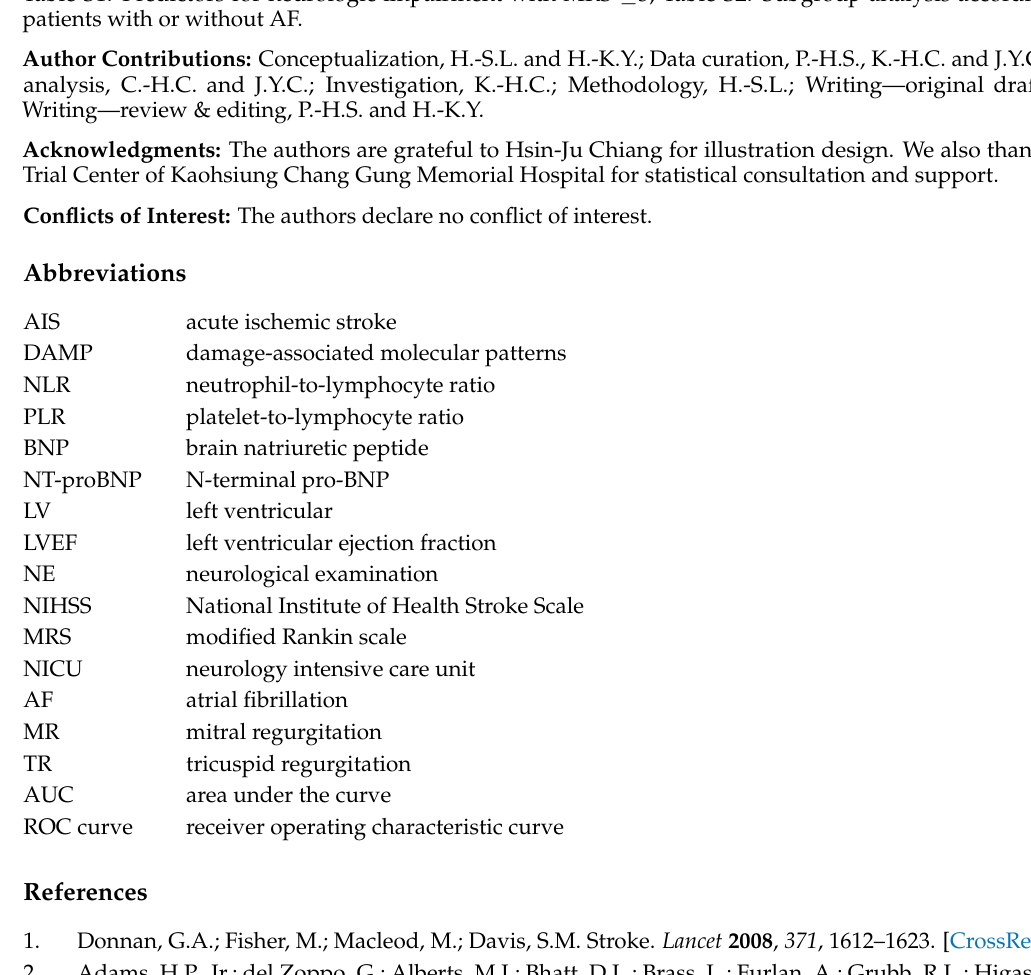
Table S1: Predictors for neurologic impairment with MRS ≥ 3, Table S2: Subgroup analysis according to AIS patients with or without